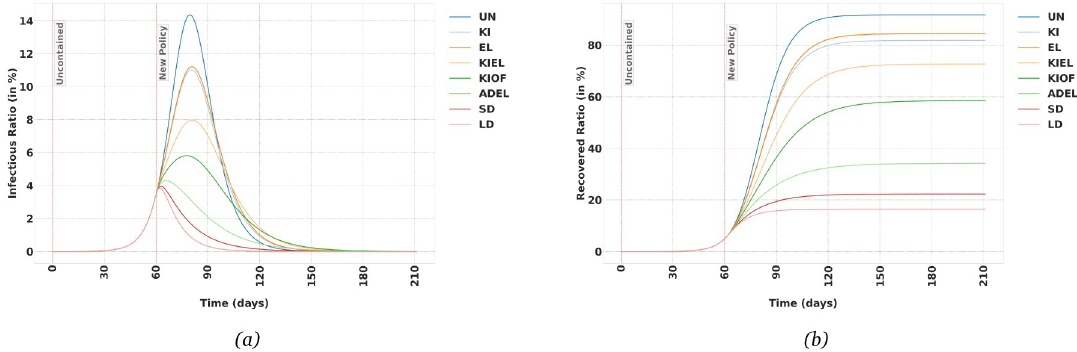
Fig 2. Effects of different suppression policies (as defined in Table 2) in Germany, when the population is uncontained for the first 60 days of the spread of the virus. (a) Infectious (b) Recovered trajectory.